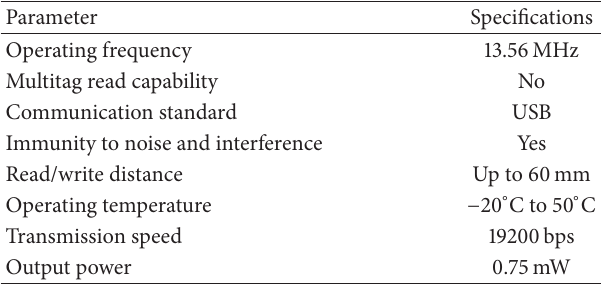
Table 1: Technical specifications of RFID reader used in our study.